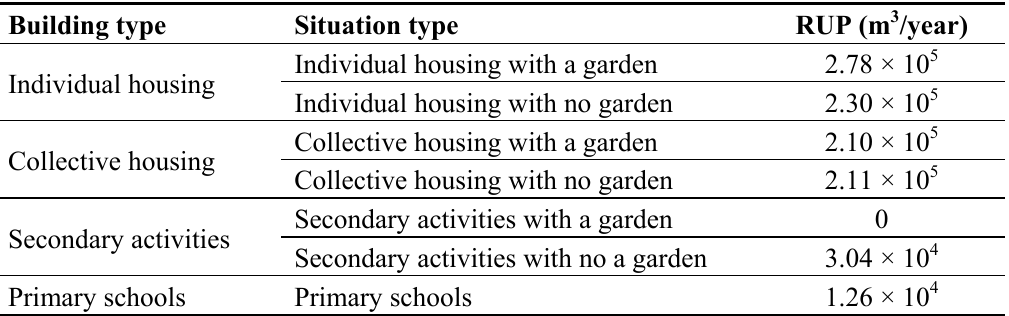
Table 7. “RUP” calculations by situation type for Colombes.